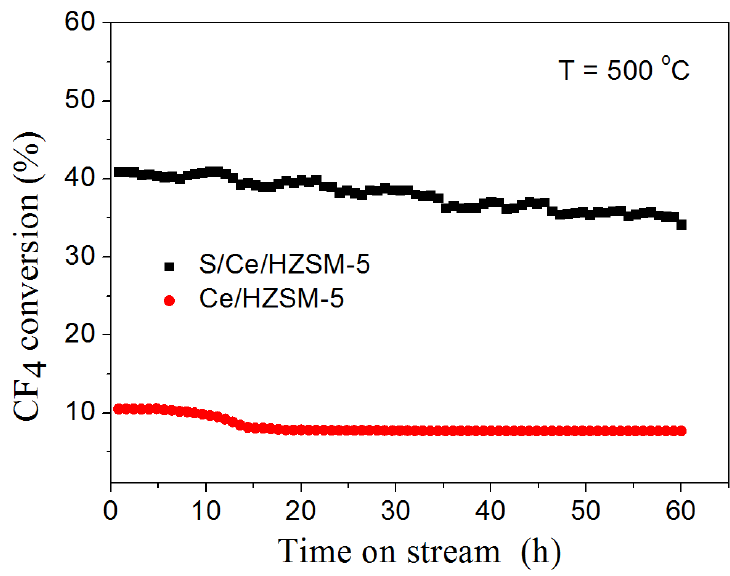
Figure 6. CF 4 conversion over catalysts with time on stream.